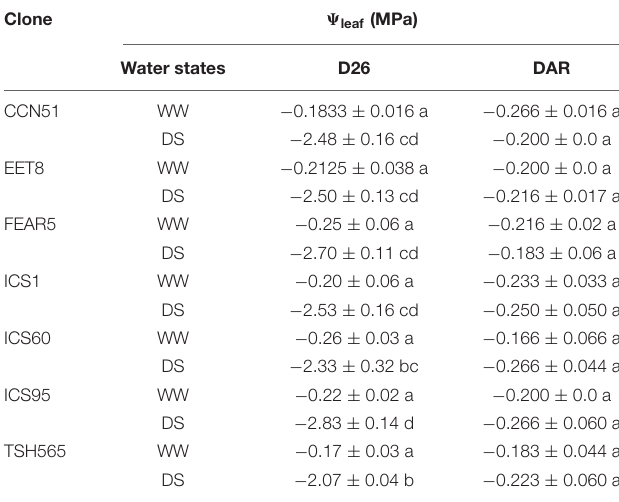
TABLE 3 | Leaf water potential ( (cid:57) leaf ) of the seven cacao clones under different water states.